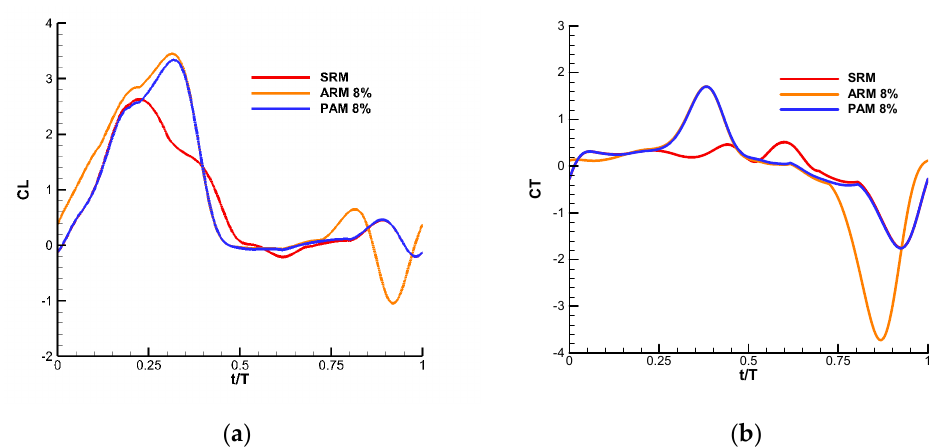
Figure 10. Time histories of C L and C T during one cycle of hovering motion for three flapping modes. ( a ) The profile of C L; ( b ) the profile of C T. ( a ) The profile of C L; ( b ) the profile of C